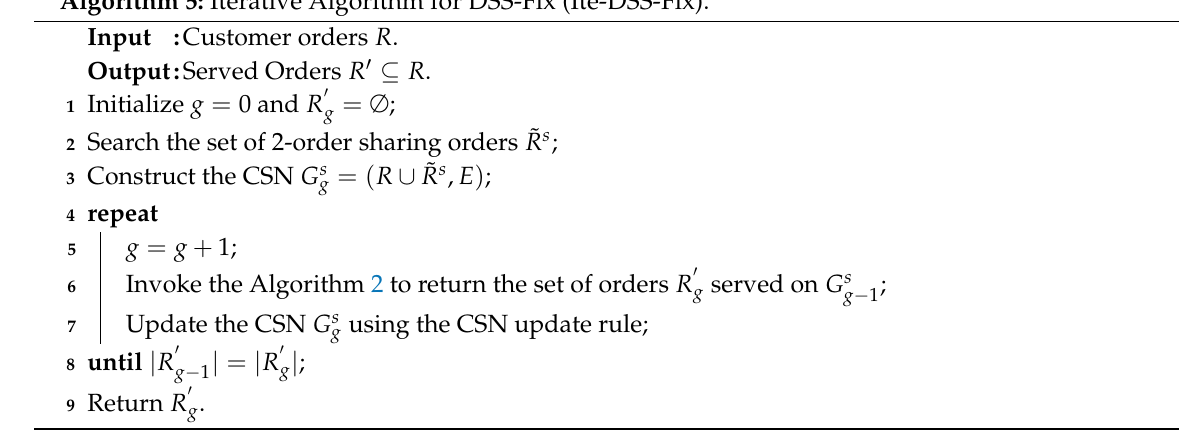
Algorithm 5: Iterative Algorithm for DSS-Fix (Ite-DSS-Fix). Input : Customer orders R